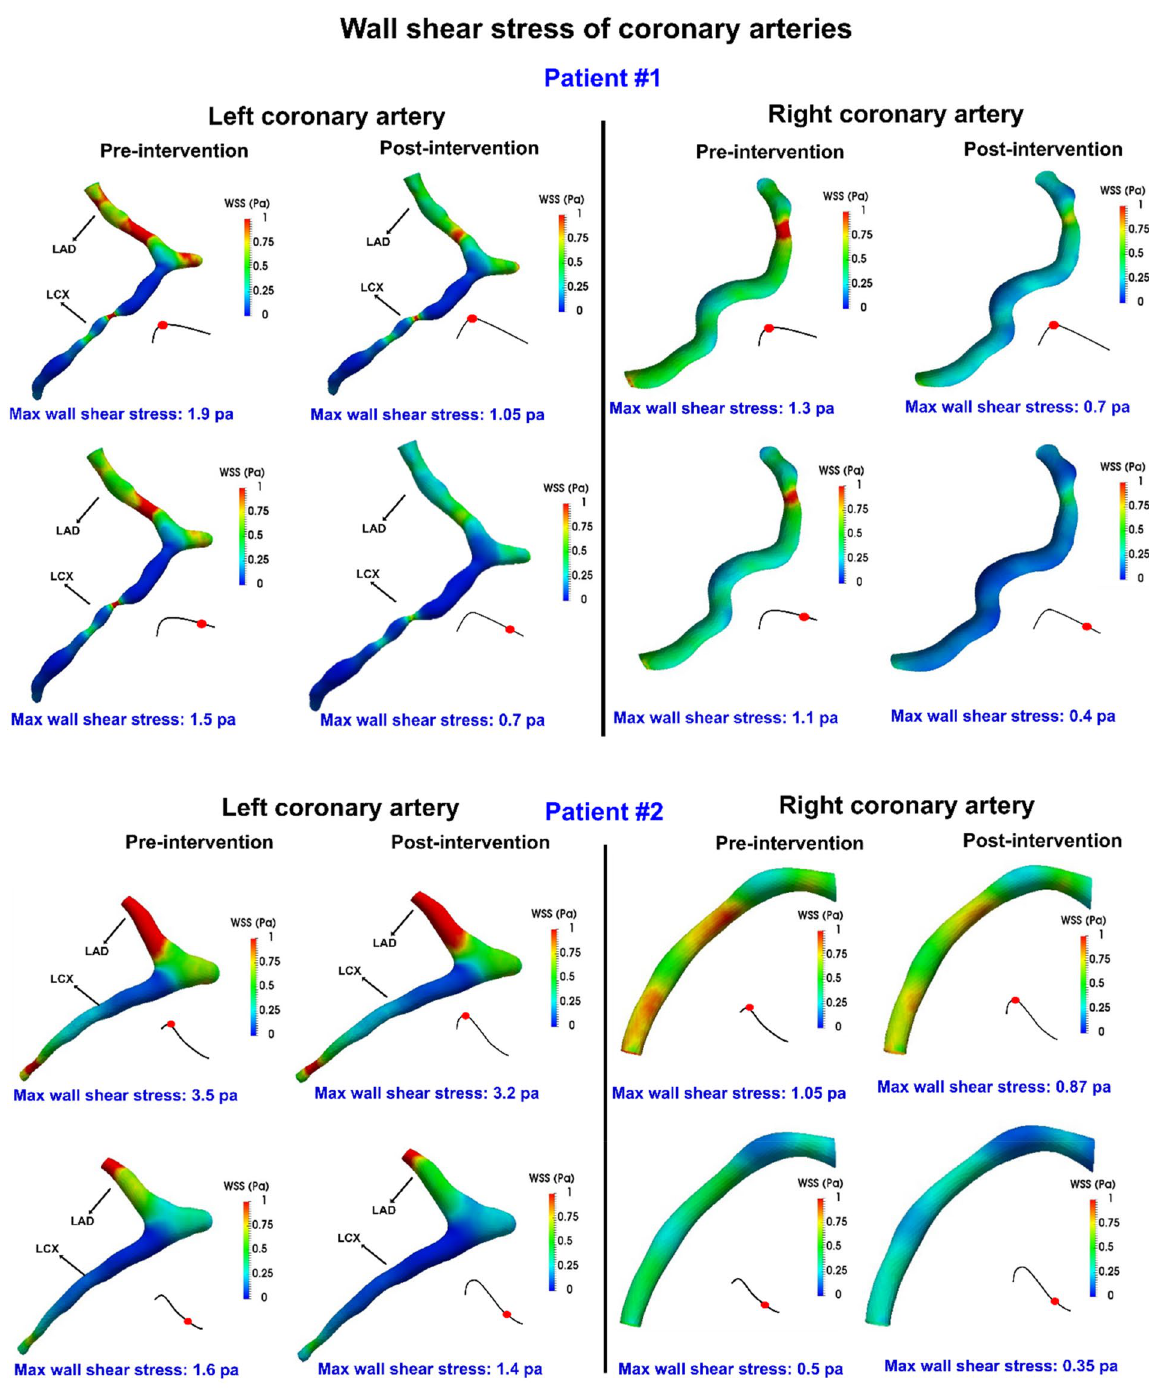
Figure 13. 3D distribution contours of wall shear stress at peak diastole in patient#1 and patient#2 between baseline and 90-day